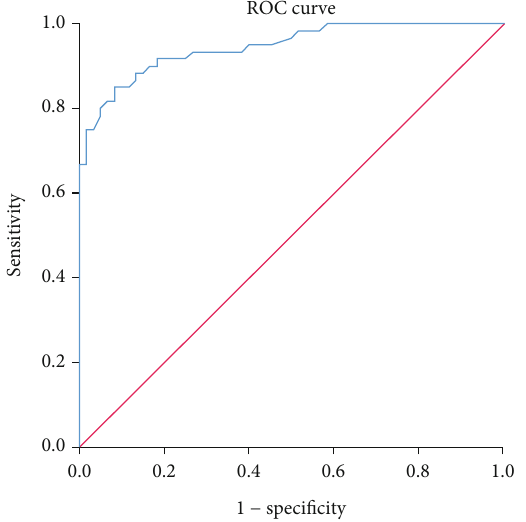
Figure 2: ROC curve for the ability of baPWV to detect DN. The area under the ROC curve was 0.946, with a 95% CI of 0.908 – 0.983, indicating that baPWV measurement is an e ff ective method for the detection of EDN. The optimal cut-o ff value of baPWV was 1716 cm/s, with a sensitivity of 91.7% and a speci fi city of 81.7%.